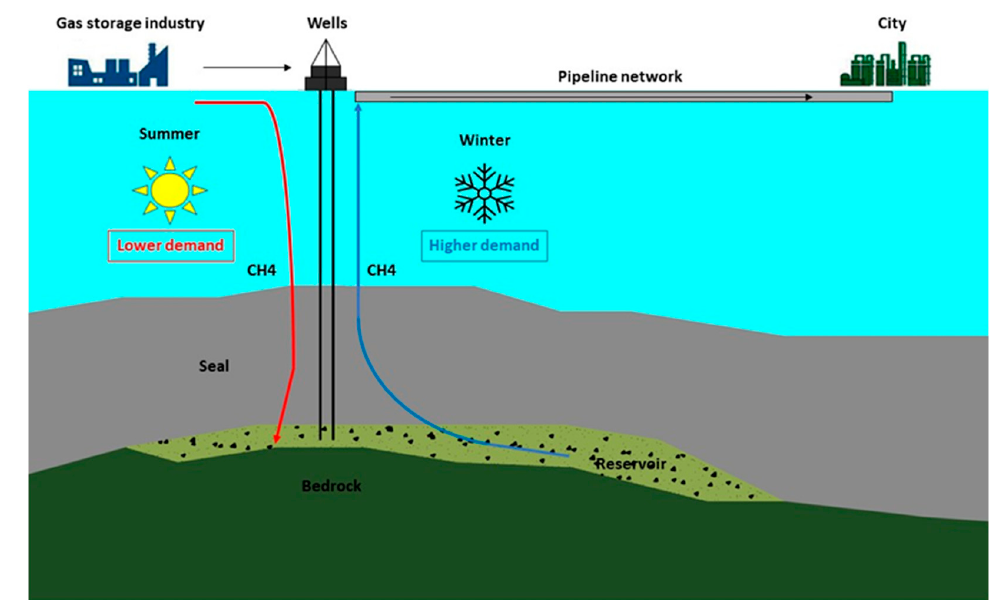
Figure 1. The underground gas storage useful for creating strategic reserves of natural gas. On the left (red color): the CH 4 injection during the summer when demand is lower; while on the right (blue color): the methane withdrawal to meet winter’s increased consumer demand.